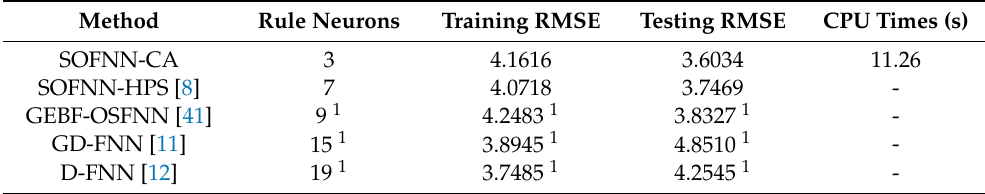
Table 3. Comparison of different methods under M-G